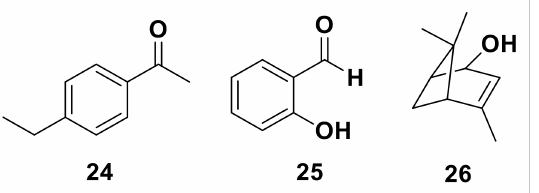
Figure 7. The chemical structure of 4-ethylacetophenone 24 , salicylaldehyde 25 and ( S )- cis -verbenol 26 , compounds shown to elicit a response to the broadly tuned OR ApisOR4 from A. pisum